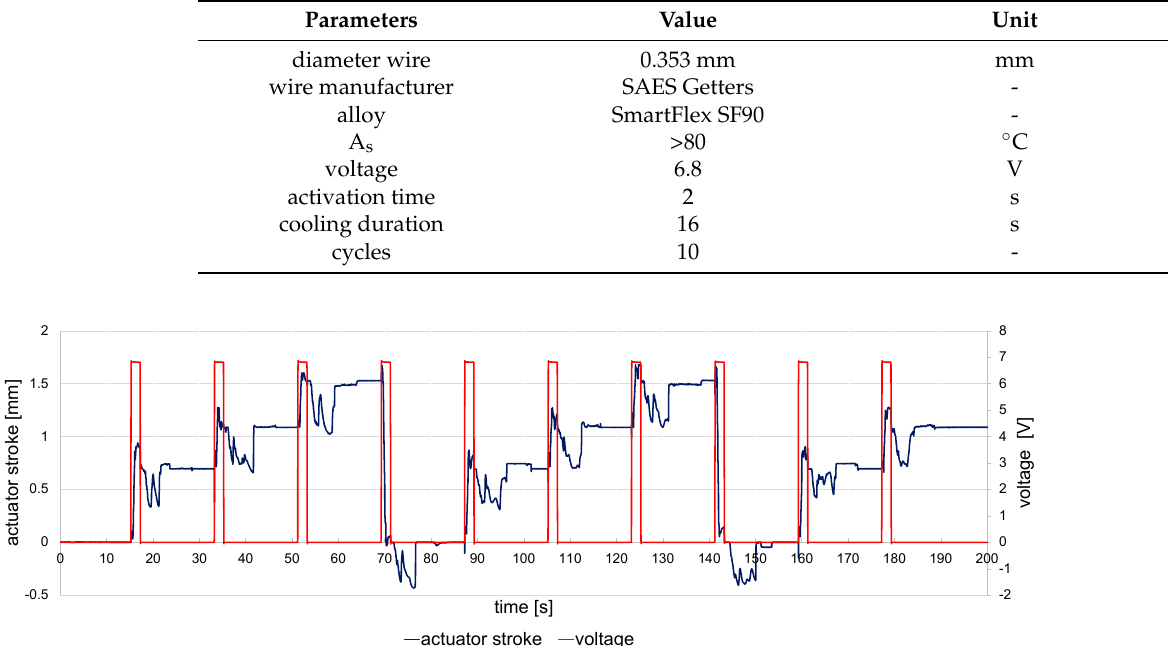
Table 5. Parameters used for the wire and activation of the prototype actuator.